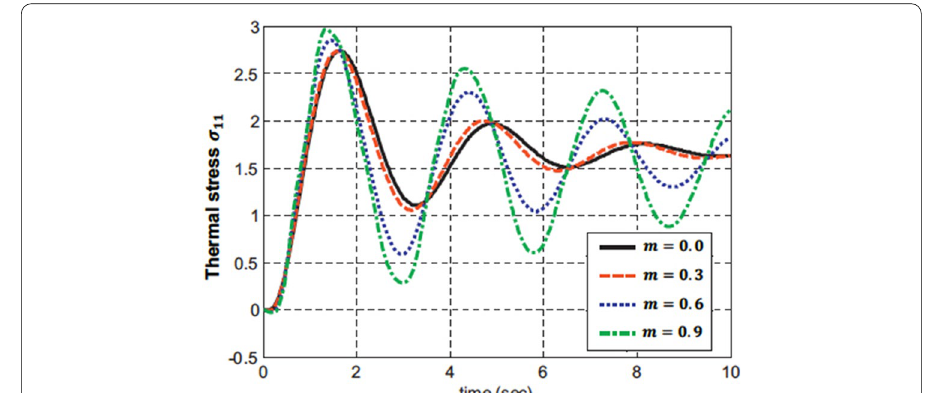
Fig. 6 Variation of the nonlinear thermal stress σ 11 with time τ for different values of functionally graded parameter m